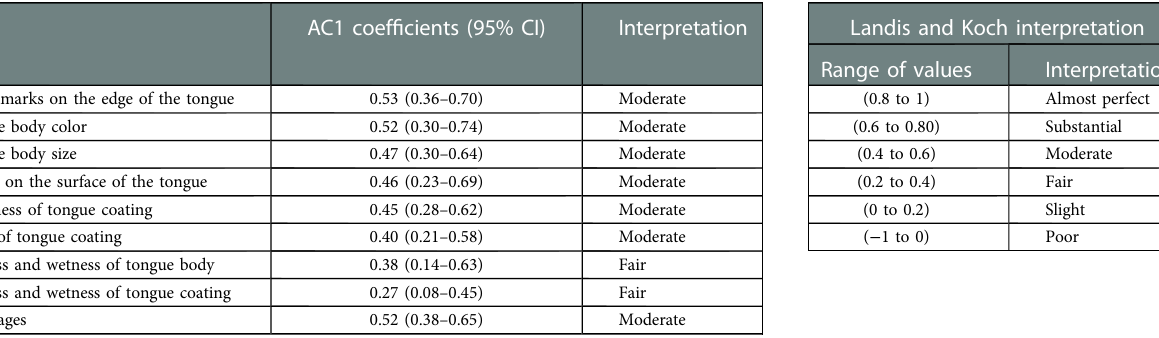
TABLE 3 Interrater reliability analysis (Study 1).